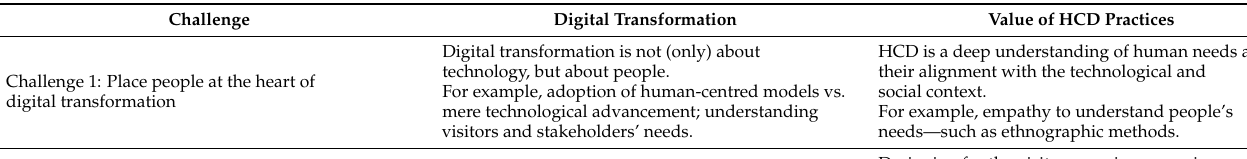
Table 1. The five digital transformation challenges and the potential contributions of